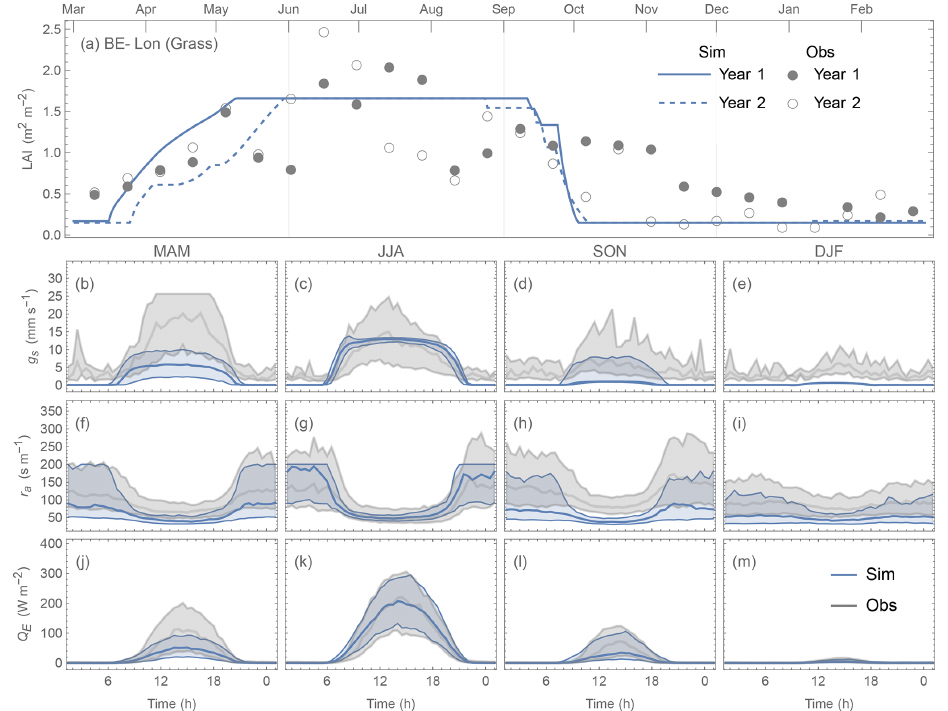
Figure 23. As Fig. 19, but for BE-Lon (Grass, PS = 0.88).